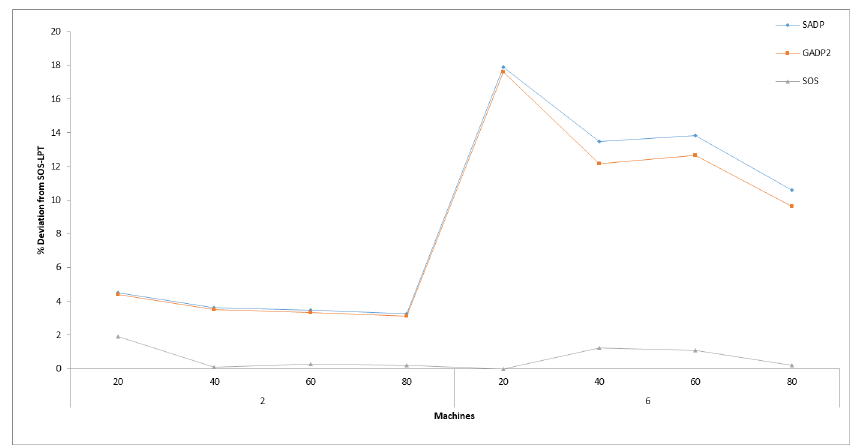
Fig 4. Percentage deviation of each algorithm with SOS-LPT as the control algorithm.